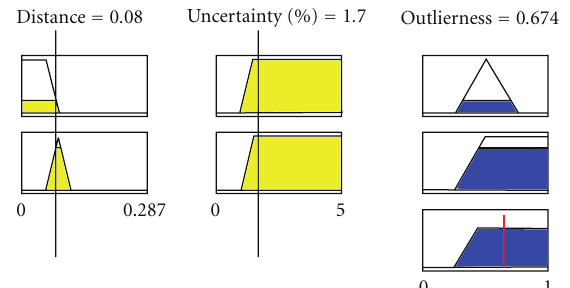
Figure 4: An application example (only activated rules r3 and r6 are